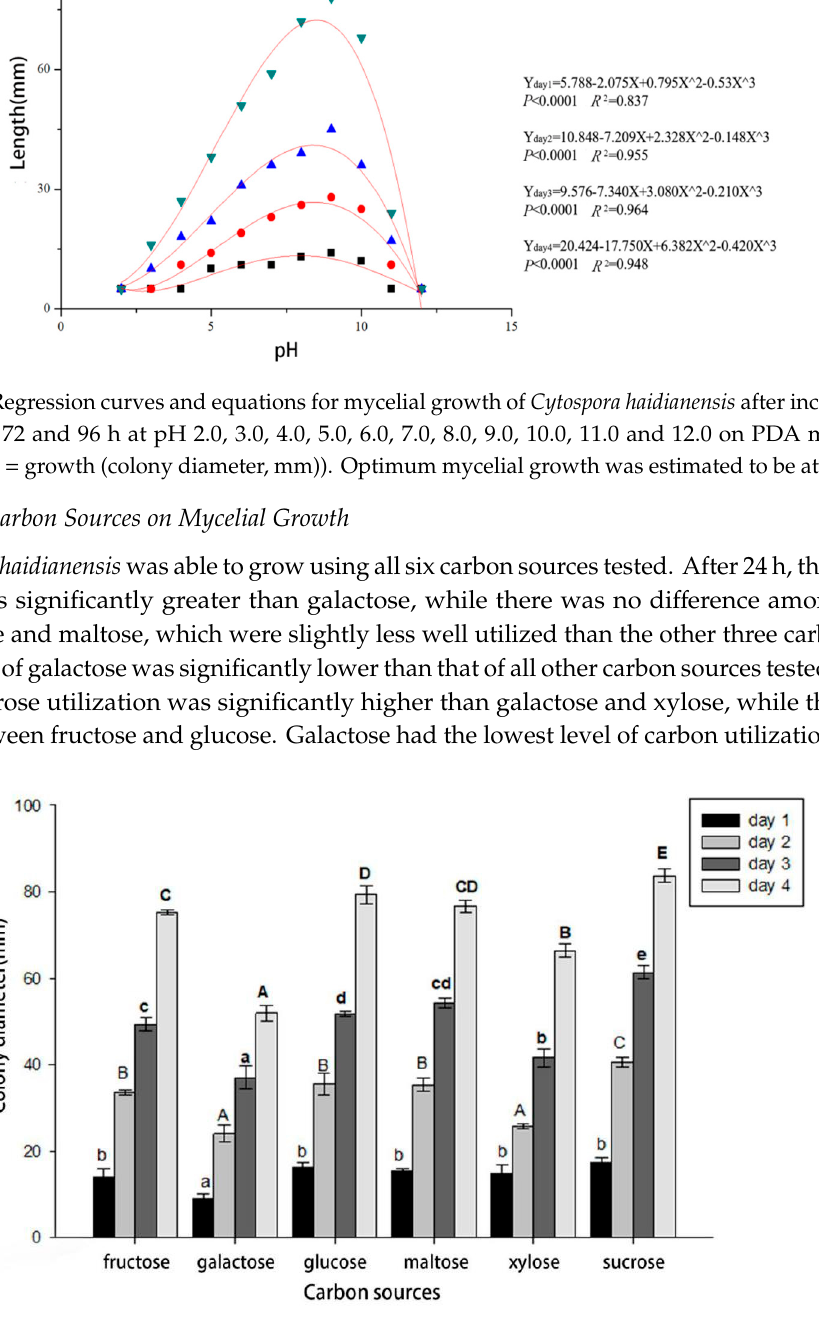
Figure 7. Effects of carbon source on growth of Cytospora haidianensis . Bars with uppercase or lowercase letters represent significant differences after, respectively, 24, 48, 72 and 96 h incubation, according to HSD tests at the p < 0.05 level.